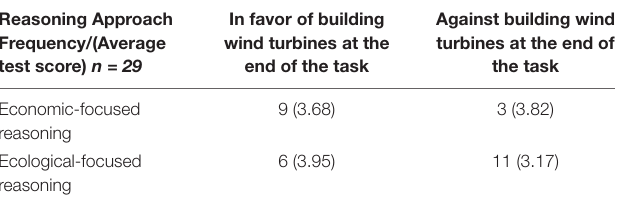
TABLE 6 | Perspective of reasoning (local council included or not) and decision against or in favor of wind turbines at the end of the tasks. Reasoning Approach